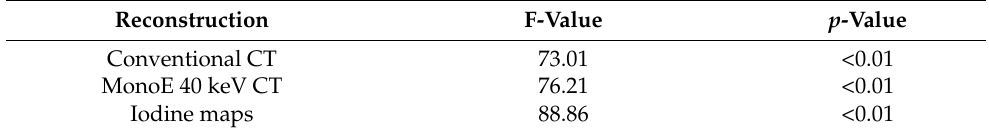
Figure 1. Distribution of ratio between HU values and iodine concentrations of the tumor and the aorta measured for different cellularity regions in conventional, monoE 40 keV and iodine map images. Table 3. F-statistics for normalized values of low, intermediate and high cellularity level tumor regions for conventional, monoE 40 keV and iodine map reconstructions.